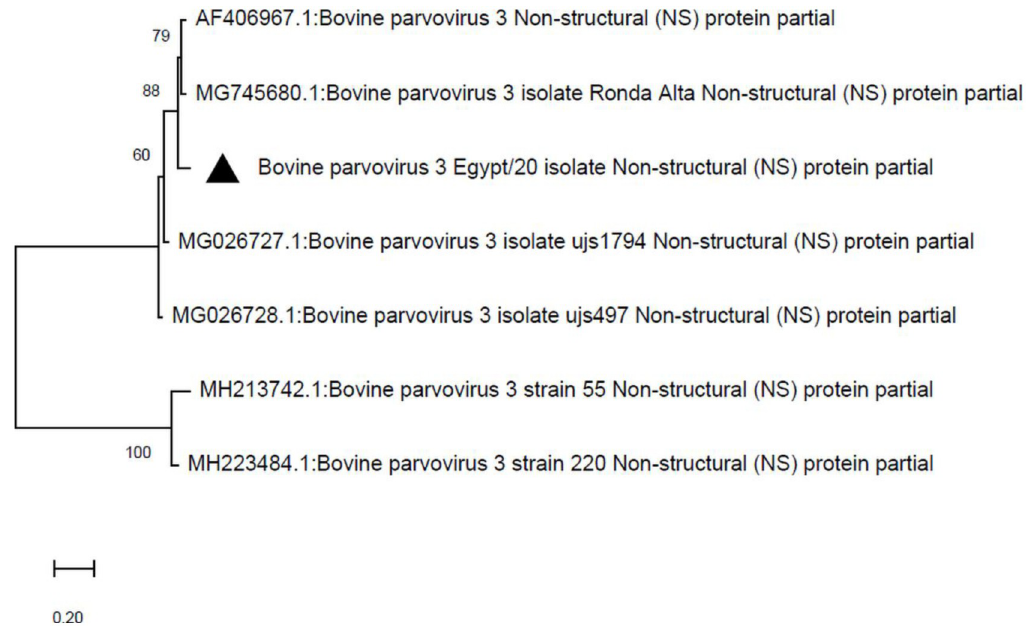
Fig 4. Phylogenetic analysis of the partial NS protein gene of BPV-3. The evolutionary history was inferred using the neighbor-joining method [20]. The percentages of replicate trees in which the associated taxa clustered together in the bootstrap test (1000 replicates) are shown next to the branches [21]. The evolutionary distances were computed using the maximum composite likelihood method [22] and are shown as the number of base substitutions per site. The codon positions included were 1 st + 2 nd + 3 rd + Noncoding. Evolutionary analyses were conducted in MEGA X